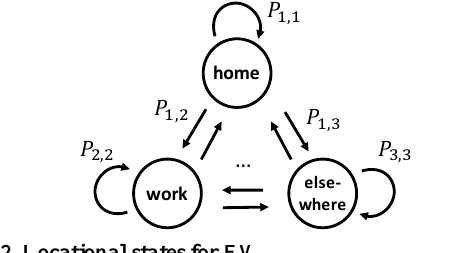
Fig. 2. Locational states for EV